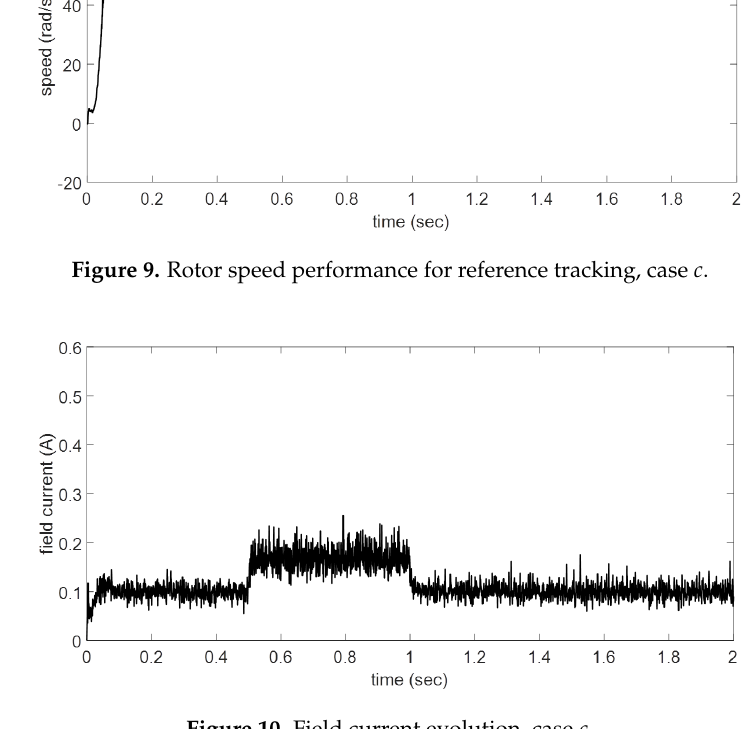
Figure 10. Field current evolution, case c